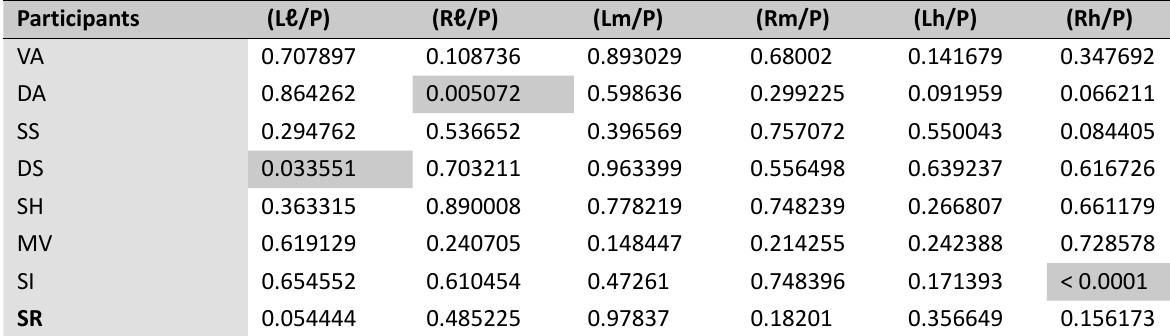
Table 1. Shapiro-Wilk normality test p-values for the peak power outputs for the left and right legs.